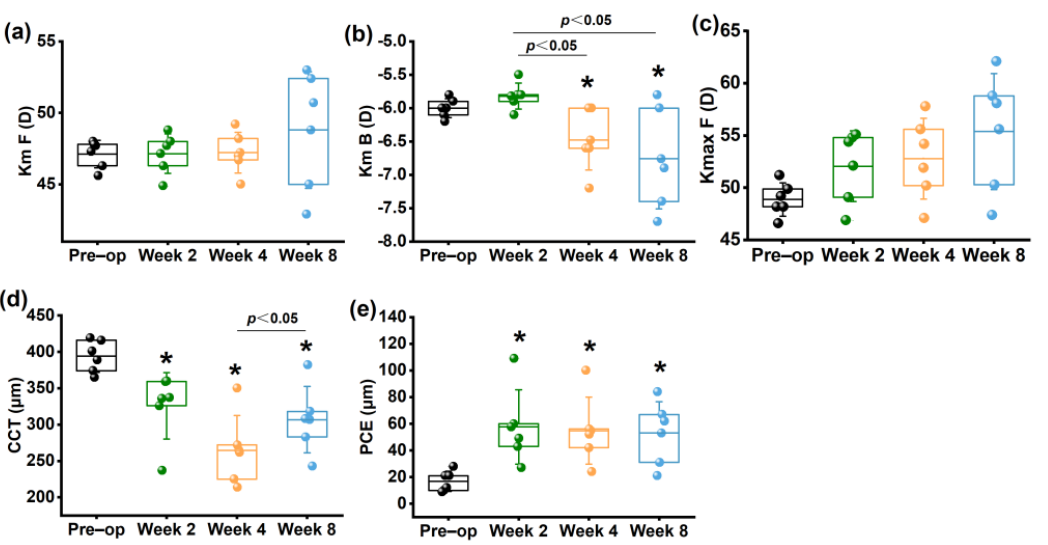
Figure 3. Changes in morphologic parameters measured by Pentacam. ( a ) Km F; ( b ) Km B; ( c ) Kmax F; ( d ) CCT; ( e ) PCE. * p < 0.05 vs. preoperative group.